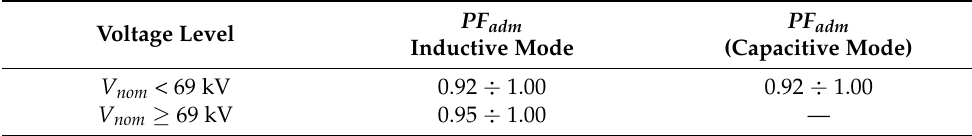
Table 3. Case study: power factor admissible range